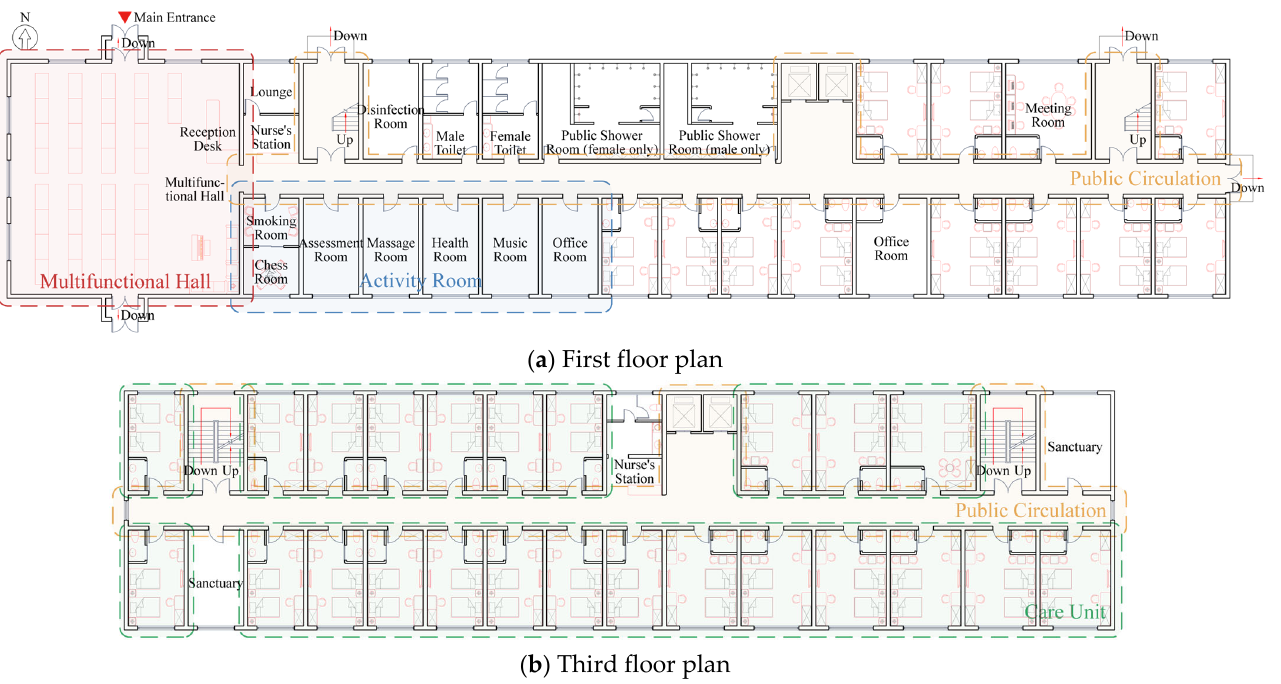
Figure 1. Research framework.